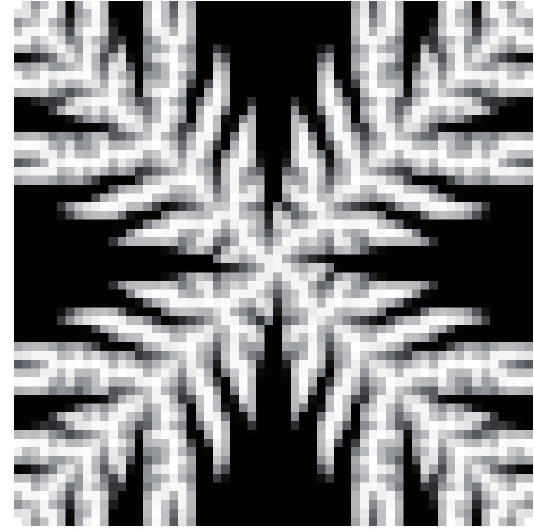
Fig. 5. Optimal distribution of high conductive material based on SIMP method.